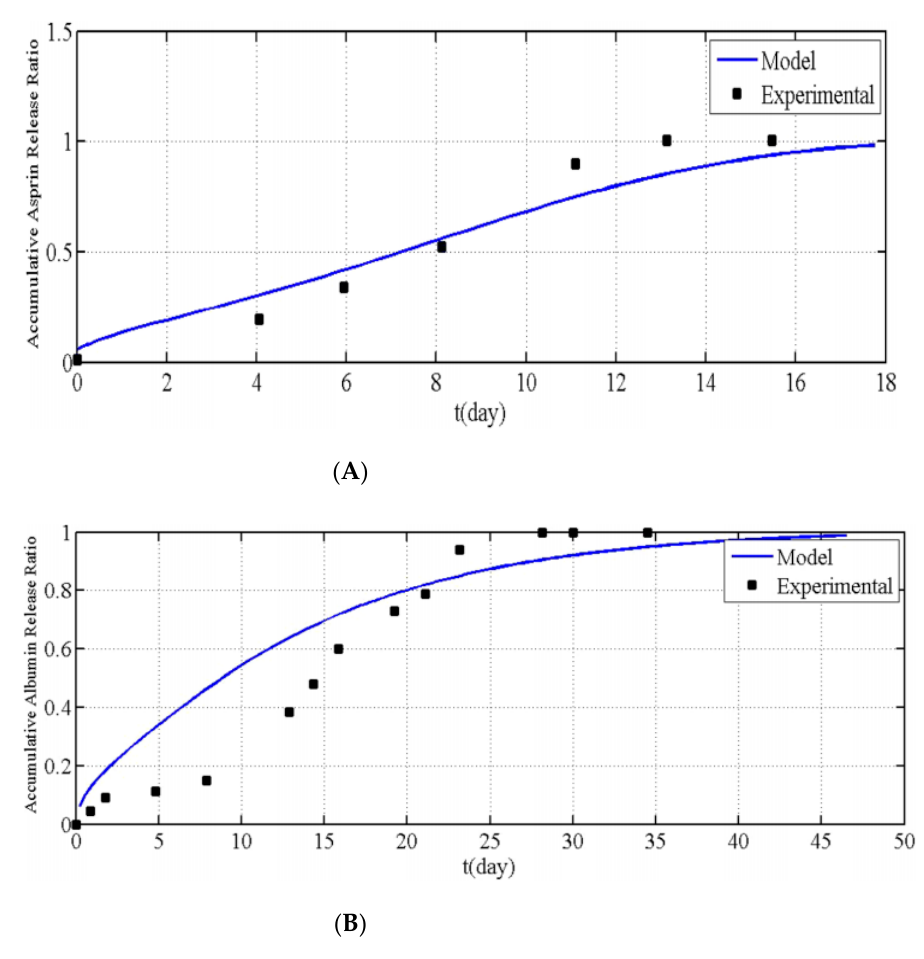
Figure 5. Relationship between sumatriptan released and time by the model (solid line) and in vitro (solid dots) for dissolving MN formulations, reproduced with permission from [32], Elsevier, 2020.